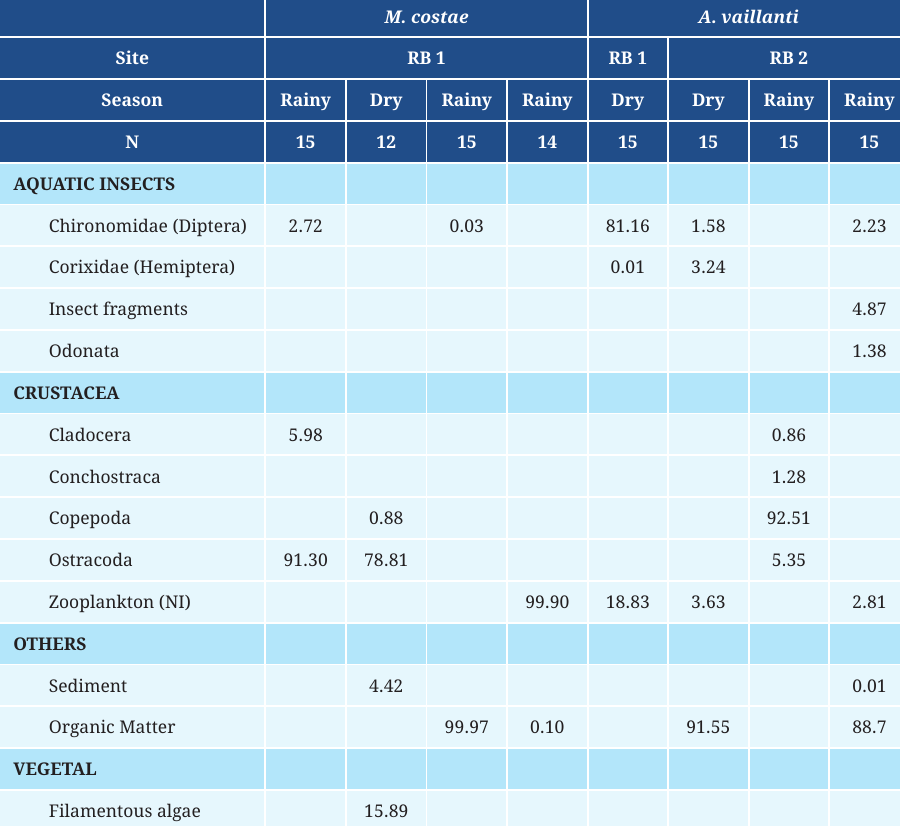
TABLE 2 | Alimentary Index (IAi) of the items consumed by non-native species of the Paraíba do Norte River basin (RB), Moenkhausia costae and Anchoviella vaillanti . N = number of non-empty stomachs analyzed; NI = not